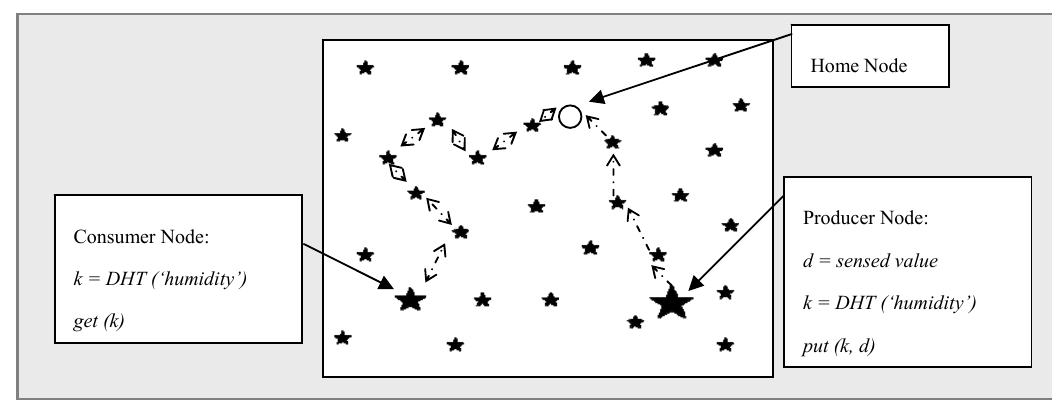
Figure 1. Geographic Hash Table